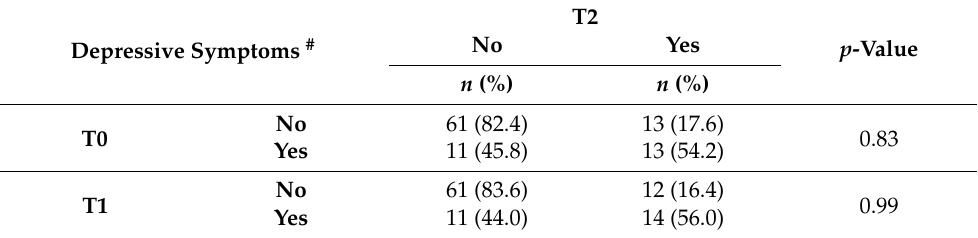
Table 3. Statistical analysis using the McNemar test between the dependent variable depressive symptoms in T0 and T1 with T2 follow-ups ( N = 99).